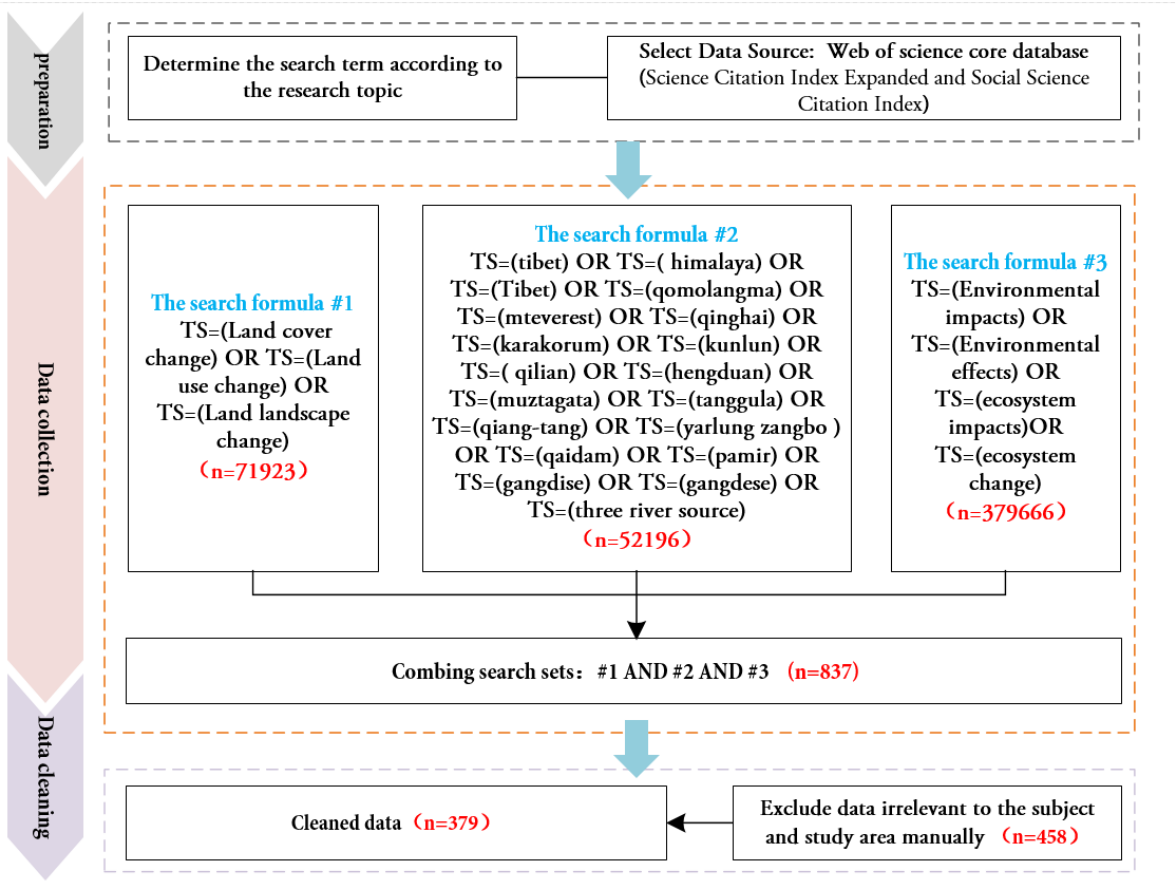
Figure 2. Data collection flow diagram.